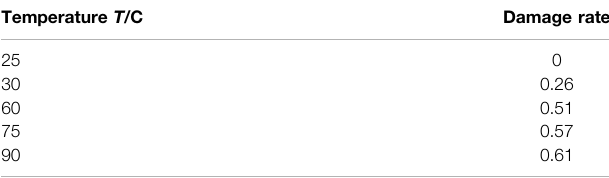
TABLE 3 | Sandstone damage rate at different